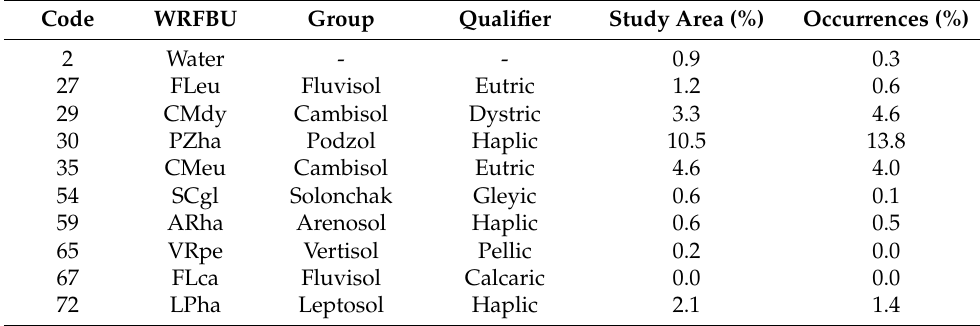
Table 2. Soil codes (WRBFU) according to the international classification